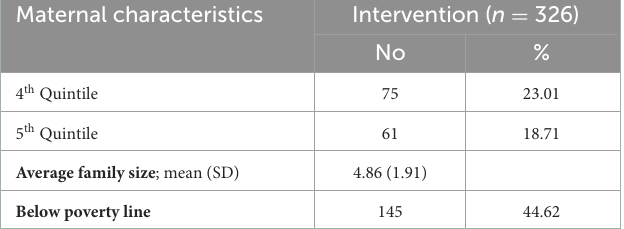
TABLE 1 Baseline characteristics of study participants in the intervention arm. Maternal